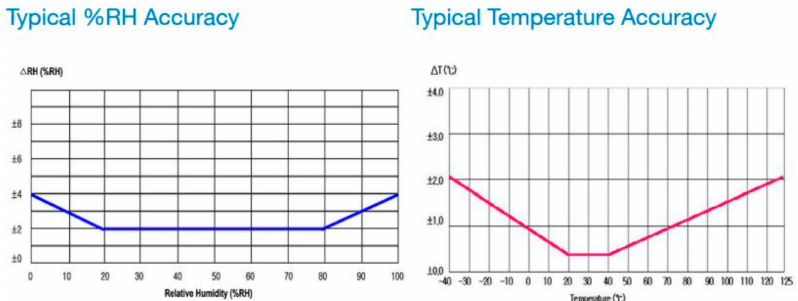
Figure 2. Accuracy of the sensors used in the case study (Telaire T9602, Humidity and Temperature Sensor, Technical